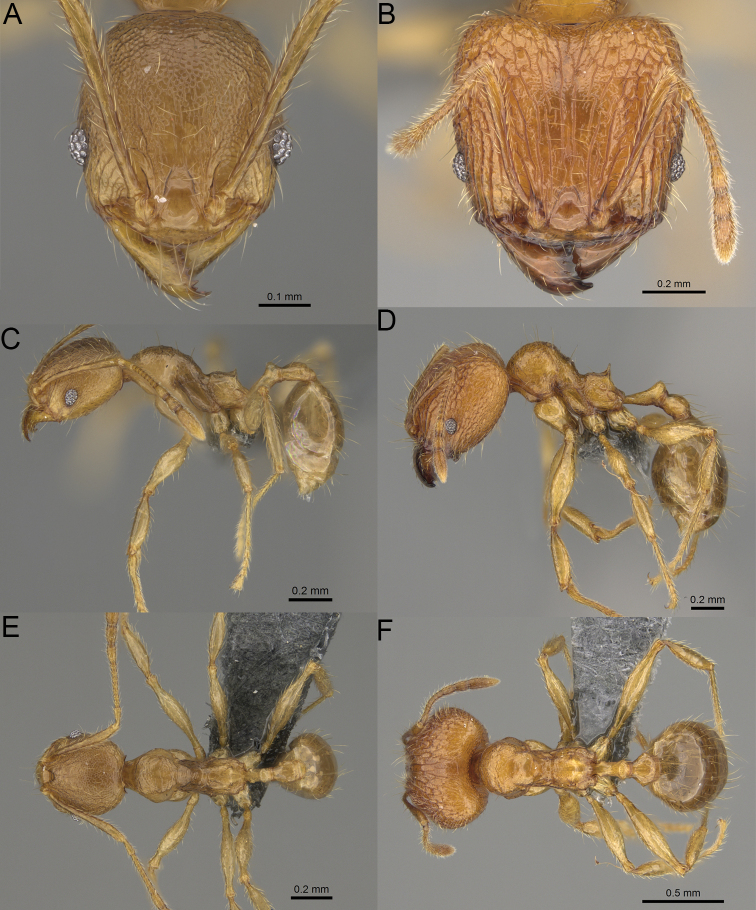
Pheidole
sparsa sp. nov., full-face view (A), profile (C), and dorsal view (E) of paratype minor worker (CASENT0923289) and full-face view (B), profile (D), and dorsal view (F) of holotype major worker (CASENT0705586).